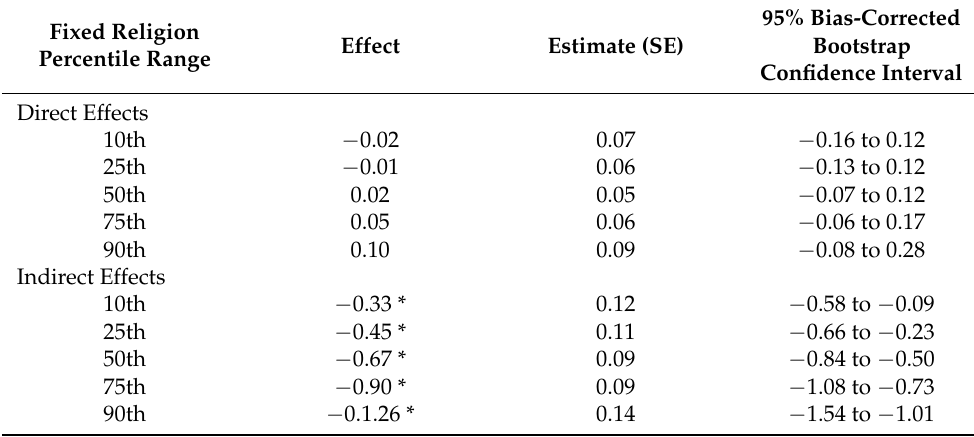
Table 5. Conditional Direct and Indirect Effects in Model with Fixed